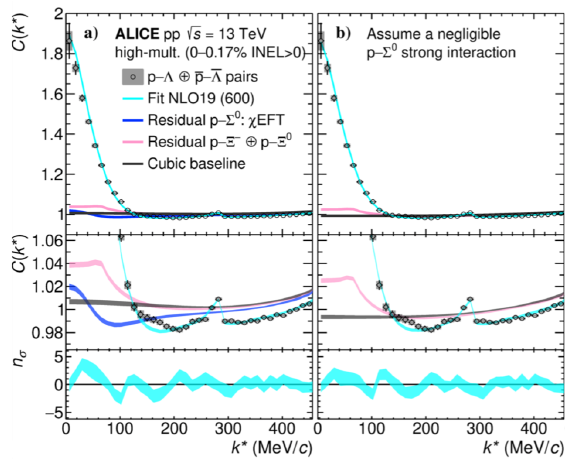
Figure 3. Figure taken from [17]. Measured p– Λ correlation and zoom in the k ∗ region with the cusp- structure due to the N Λ –N Σ coupling at k ∗ = 289 MeV / c . Lower panel: deviation between data and model in terms of n σ . The fit using NLO19 [9] chiral potential is shown. Left: fit assuming a χ EFT potential [15] for the p- Σ 0 residual. Right: fit assuming a flat p- Σ 0 residual.